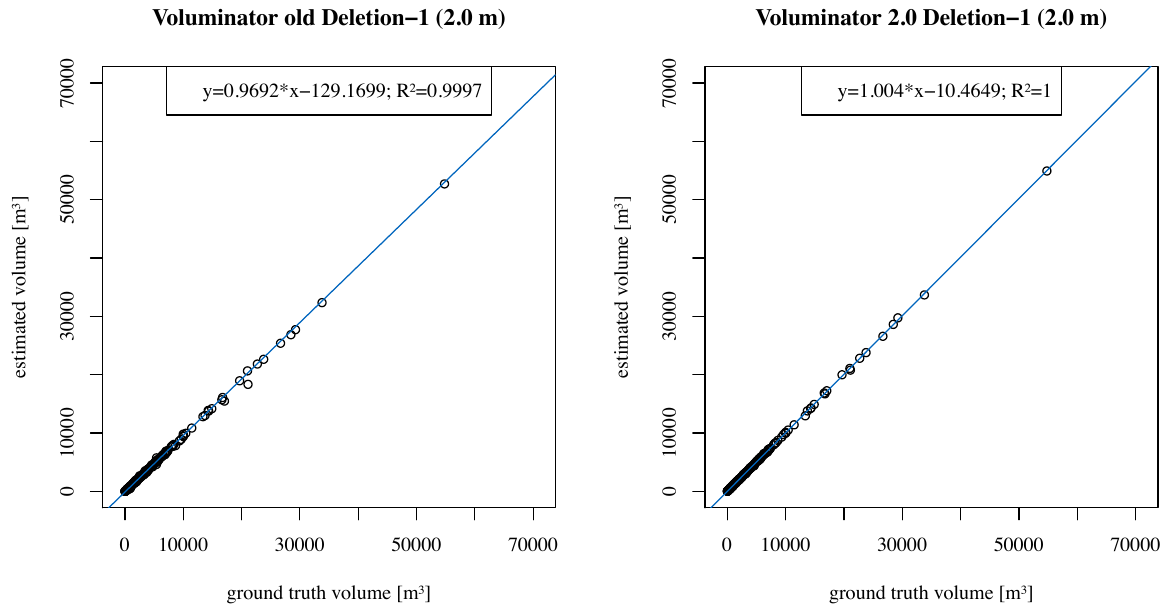
Figure 13: Scatterplot of the actual building volume and the approximated building volume for buildings with defective solid boundaries ( > 5% of the solid boundary is missing; n = 192 buildings) using the old voluminator (left) and the recursive voluminator approach at a resolution of 2 m . For the old voluminator approach the overall computation time was 1.85 minutes for the octree approach the overall computation time was 3.36 minutes.